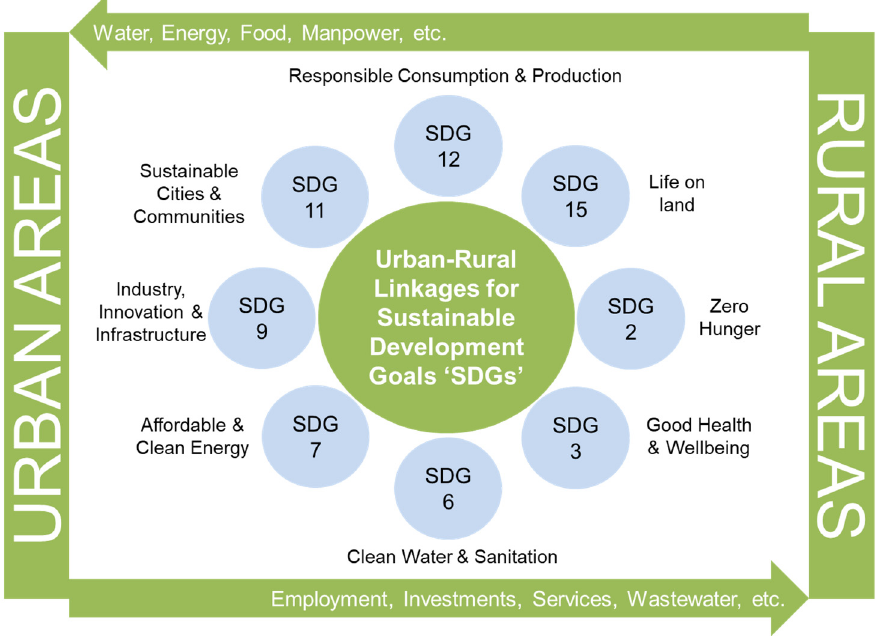
Figure 1. Conceptual diagram of urban–rural linkage with sustainable development goals (SDGs).